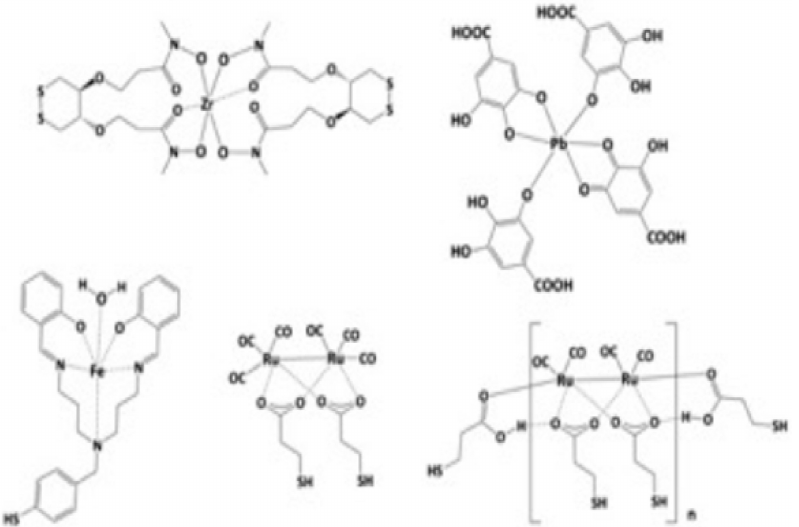
Figure 21. The example of combined complexes used in Au NP coat is carboxylate, amidate and phenolate. Reproduced with permission from reference [158], ACS,